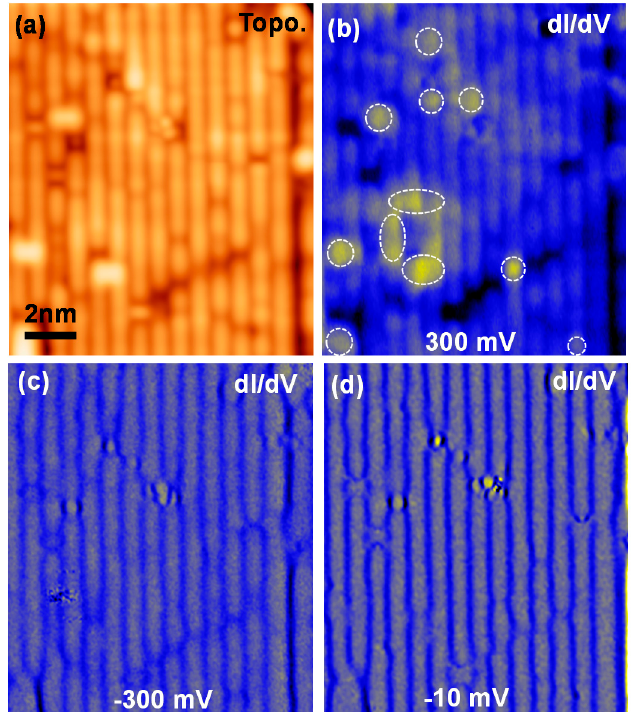
Figure 2. ( a , b ) STM image and dI/dV conductance map on Pr-Ca122 (Vs = 300 mV, It = 200 pA, modulation voltage Vac = 1 mV, f = 973 Hz, T = 4.2 K). The bright spots on the dI/dV map in ( b ) indicate the Pr-dopant positions (dashed white circles). ( c , d ) Same area with Vs = − 300 mV and − 10 mV,